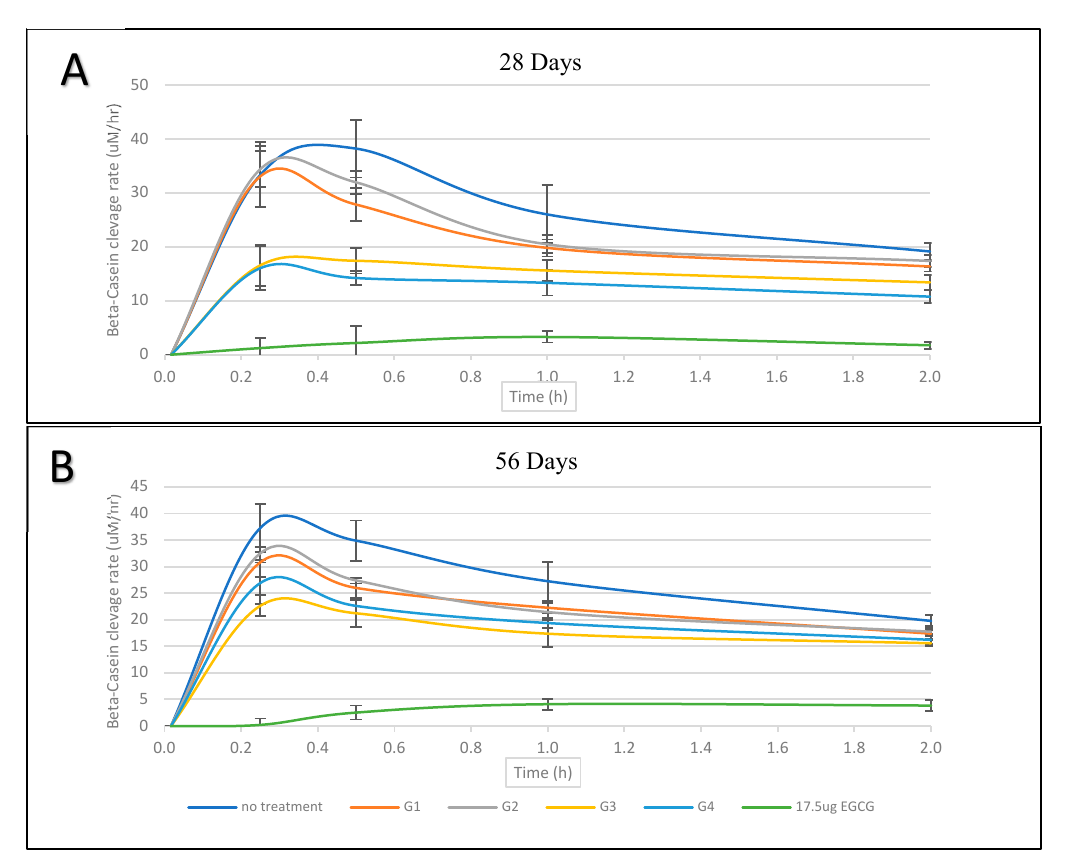
Figure 3. β -casein substrate (12.5 mg/mL) cleavage rate by MMP-9 (0.1 µg/m) at 28 days ( A ) and 56 days ( B ).